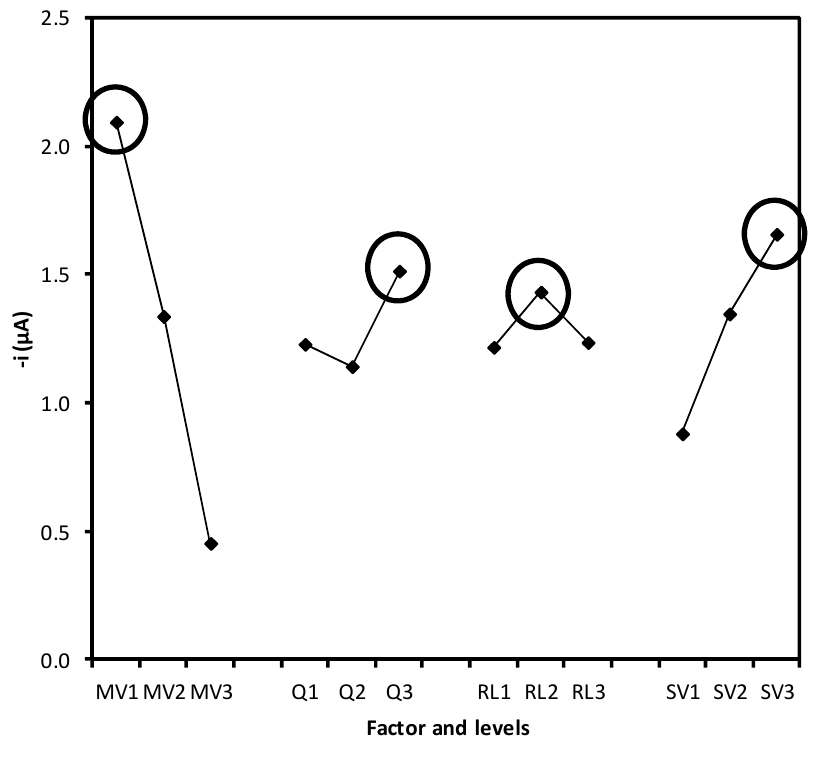
Figure 3. Effects of control factors on the mean peak height (µA) signal. MV, enzyme magnetic suspension volume; Q, flow rate; RL, reaction length; SV, sample